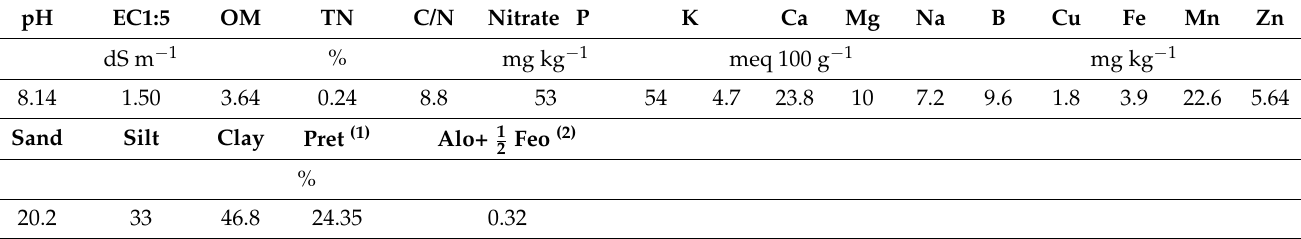
Table 3. Relevant properties of the studied